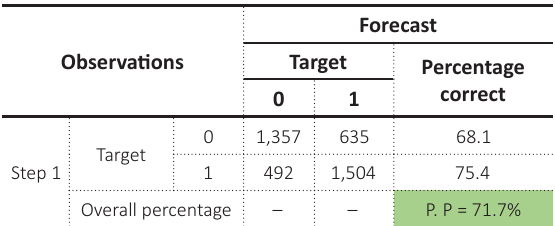
Table 3. Confusion